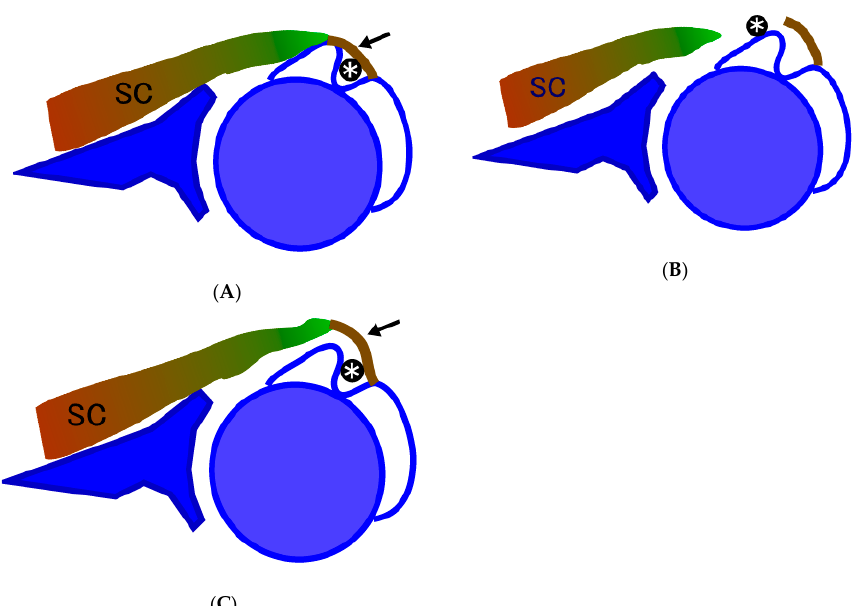
Figure 2. Schematic drawing of normal, torn, and floating subscapularis. ( A ) Intact subscapularis. SC, subscapularis; arrow, transverse humeral ligament; *, long head of the biceps tendon. ( B ) Torn subscapularis. The tendon is detached from the lesser tuberosity and is retracted medially. In many cases, long head of the biceps is subluxated. ( C ) Floating subscapularis. Subscapularis tendon is detached from the lesser tuberosity with soft tissue extension to the transverse humeral ligament is preserved. SC, subscapularis; arrow, transverse humeral ligament; *, long head of the biceps